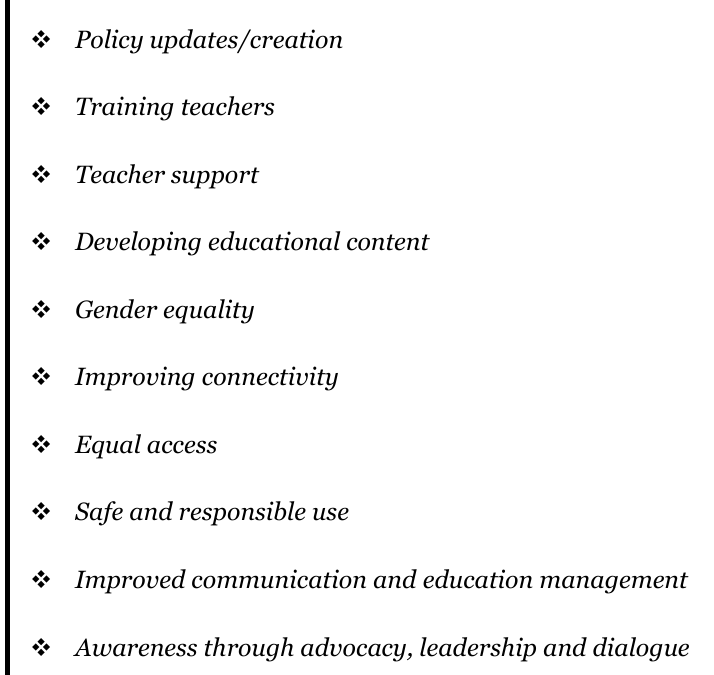
Figure 1. The 10 themes identified from UNESCO’s guidelines, based on the six phases of thematic analysis identified by Braun and Clarke